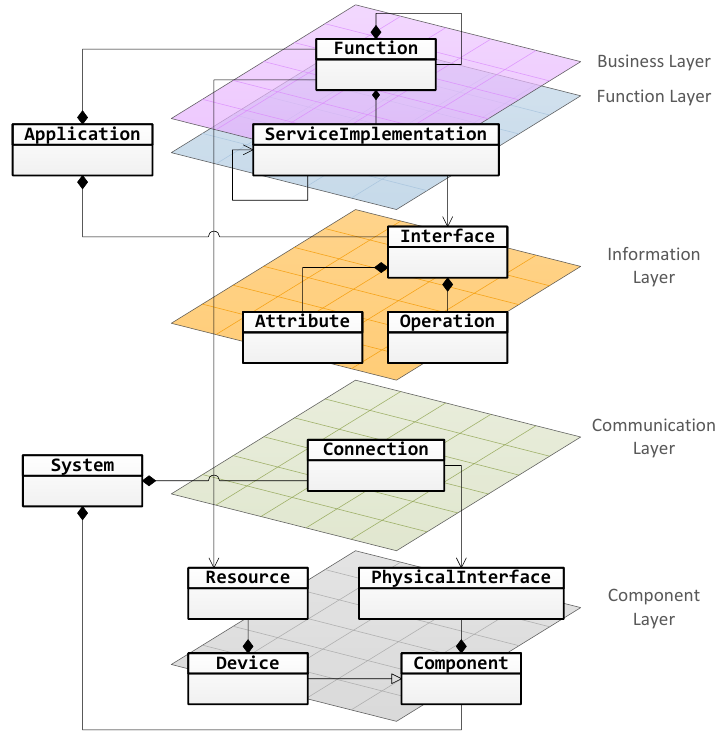
Figure 5. Simplified Unified Modeling Language (UML) representation of Power System Automation Language (PSAL)’s domain model, on top of the SGAM